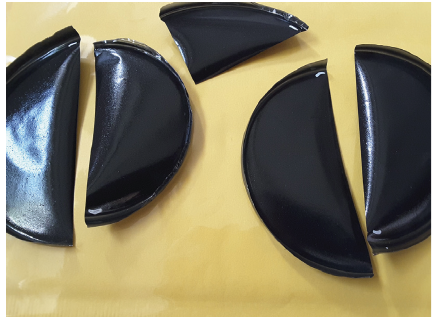
Figure 1: A photograph of the prepared